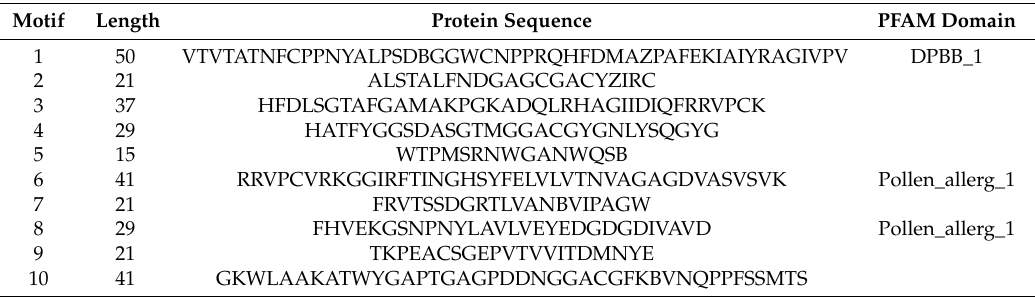
Figure 2. Phylogenetic relationships, motif compositions and gene structure of expansin genes in moso bamboo. ( A ) Phylogenetic relationships of 82 expansins in moso bamboo. They were classified into four groups: α -expansin (EXPA), β -expansin (EXPB), expansin-like A (EXLA) and expansin-like B (EXPB); ( B ) di ff erent motif compositions of expansins in moso bamboo were detected using MEME. The conserved motifs are represented by boxes with di ff erent colors and their information is listed in Table 2; ( C ) gene structure organization of expansin genes of Phyllostachys edulis ( PeEXs ). The number of introns and exons is also marked in the figure. Table 2. Detailed information of